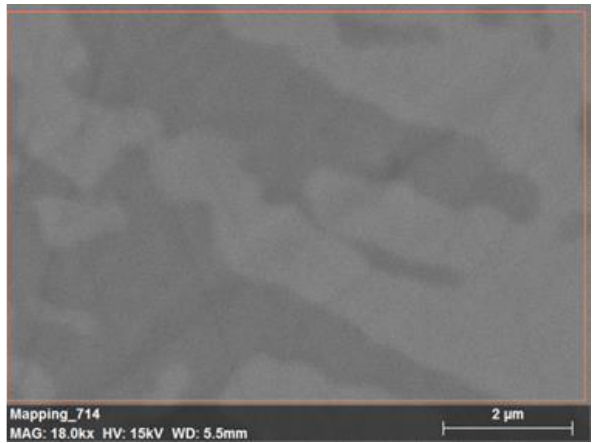
Figure 5. SEM imaging used for EDX analyses of the MnFe 0.53 Ni 0.47 Si 0.94 Al 0.06 sample quenched from 900 °C.